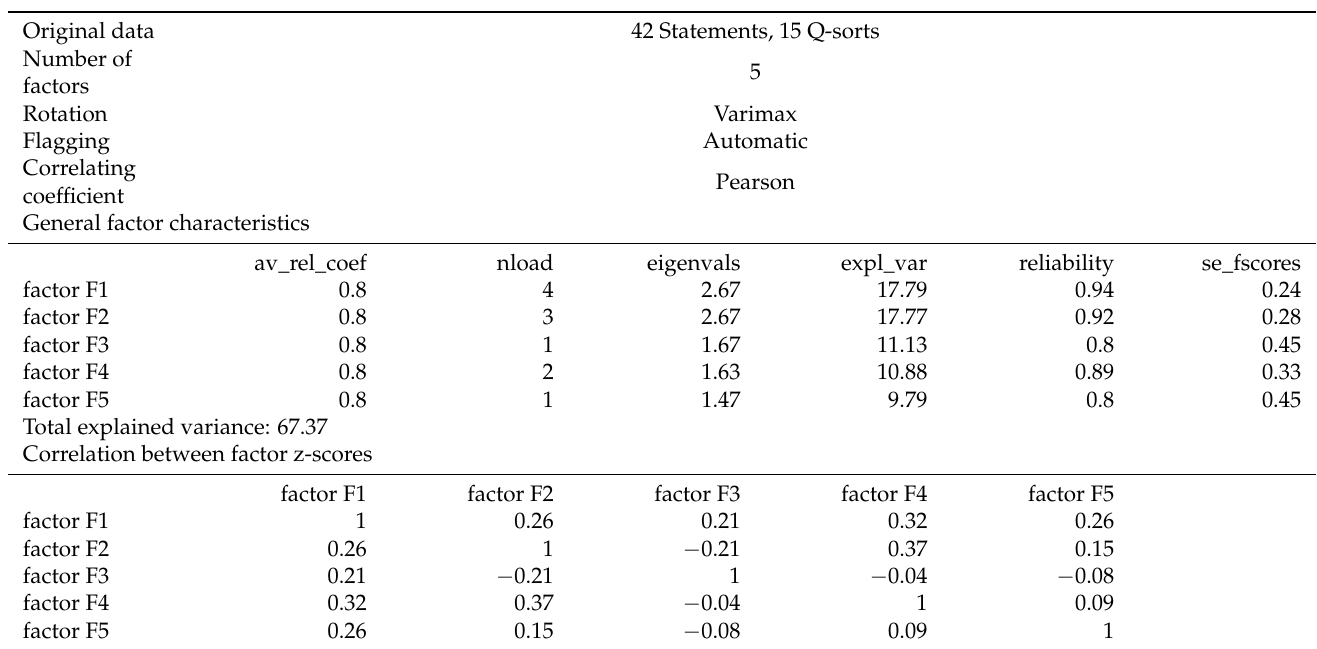
Table 3. Q-method analysis in qmethod for R.